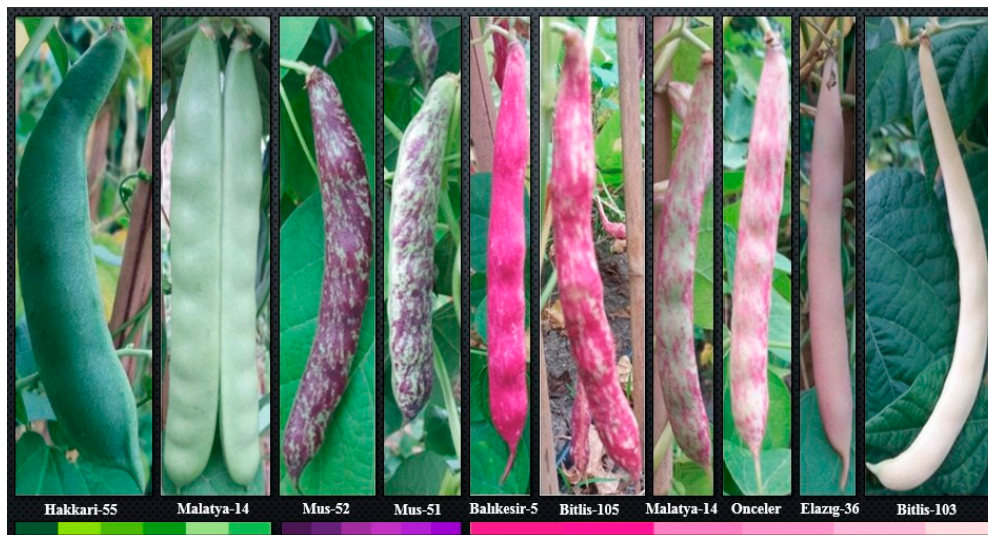
Figure 4. Pods size, shape, and color diversity in Turkish common bean germplasm.